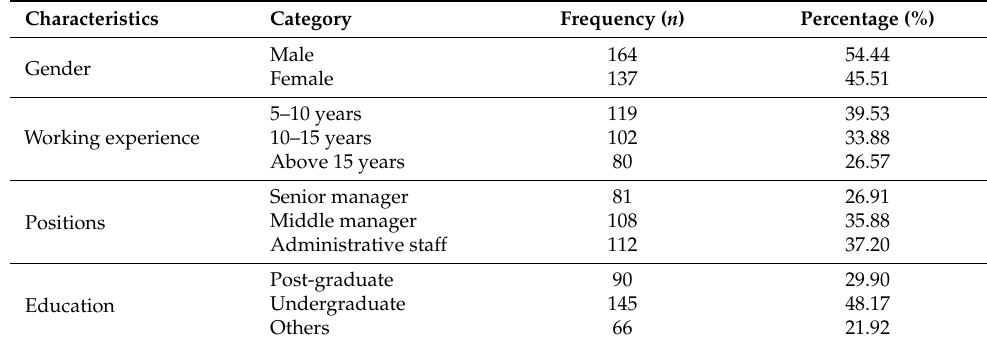
Table 1. Respondents’